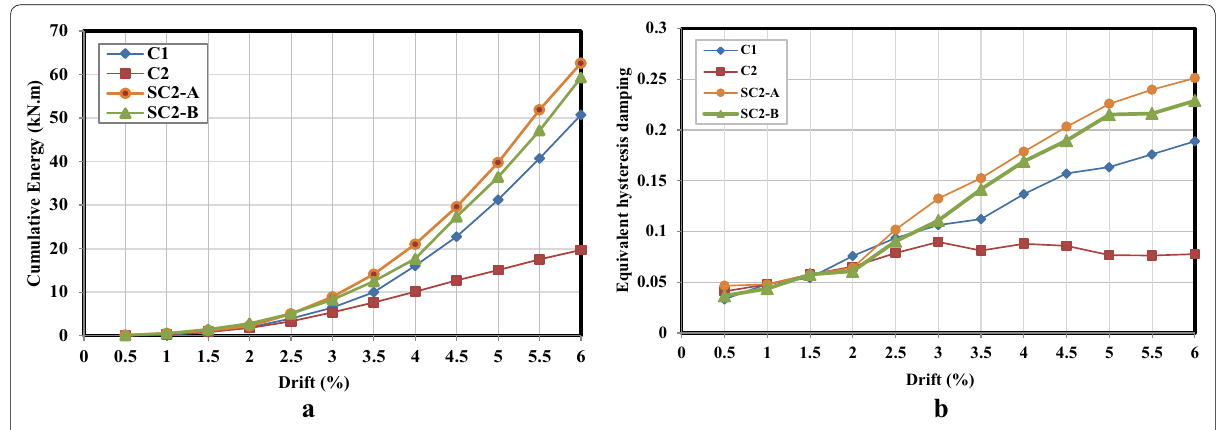
Fig. 23 a Hysteresis energy dissipation of the specimens; b equivalent hysteresis damping ratio versus